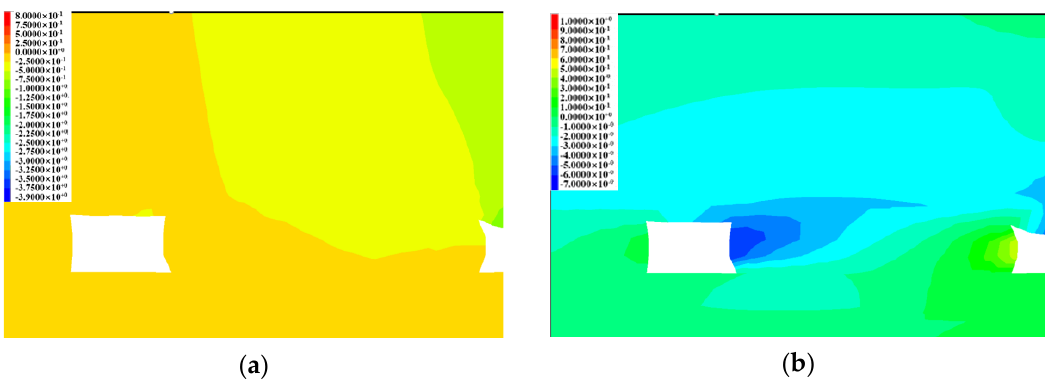
Figure 13. Displacement distribution of RAR 23205 after first mining: ( a ) vertical displacement distribution; ( b ) horizontal displacement distribution.